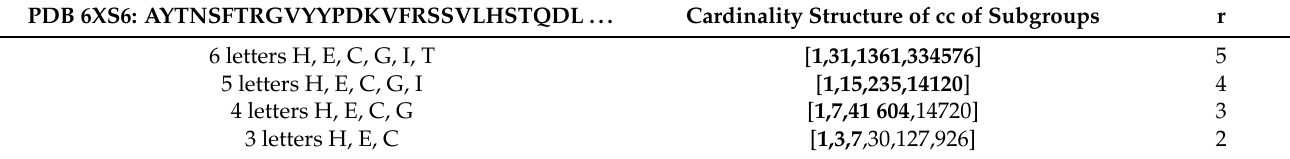
Table 2. Group analysis of the D614G variant (minus RBD) of the SARS-CoV-2 spike protein. The bold numbers mean that the cardinality structure of cc of subgroups of G fits that of the free group F r − 1 when the encoding makes use of r letters. In the last column, r is the first Betti number of the generating group f p .